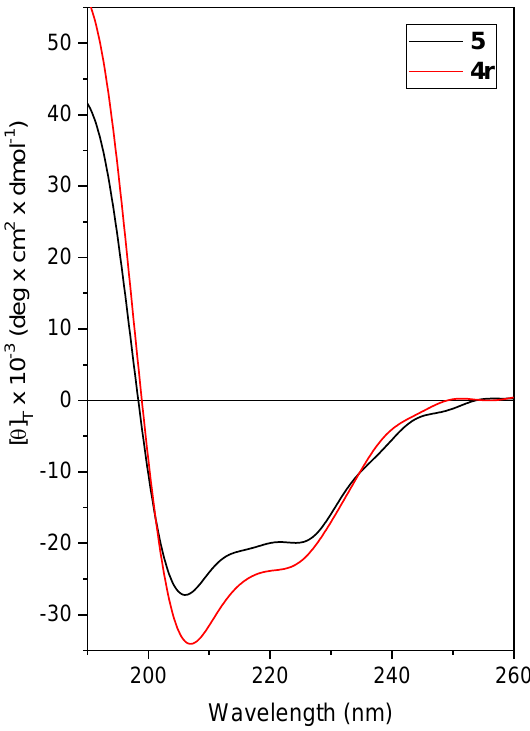
Figure 7. CD spectra acquired for 4r and 5 in vitro, in the presence of fungal spores in phosphate buffer pH 7, 25 °C. Peptide concentration: 50 µM.